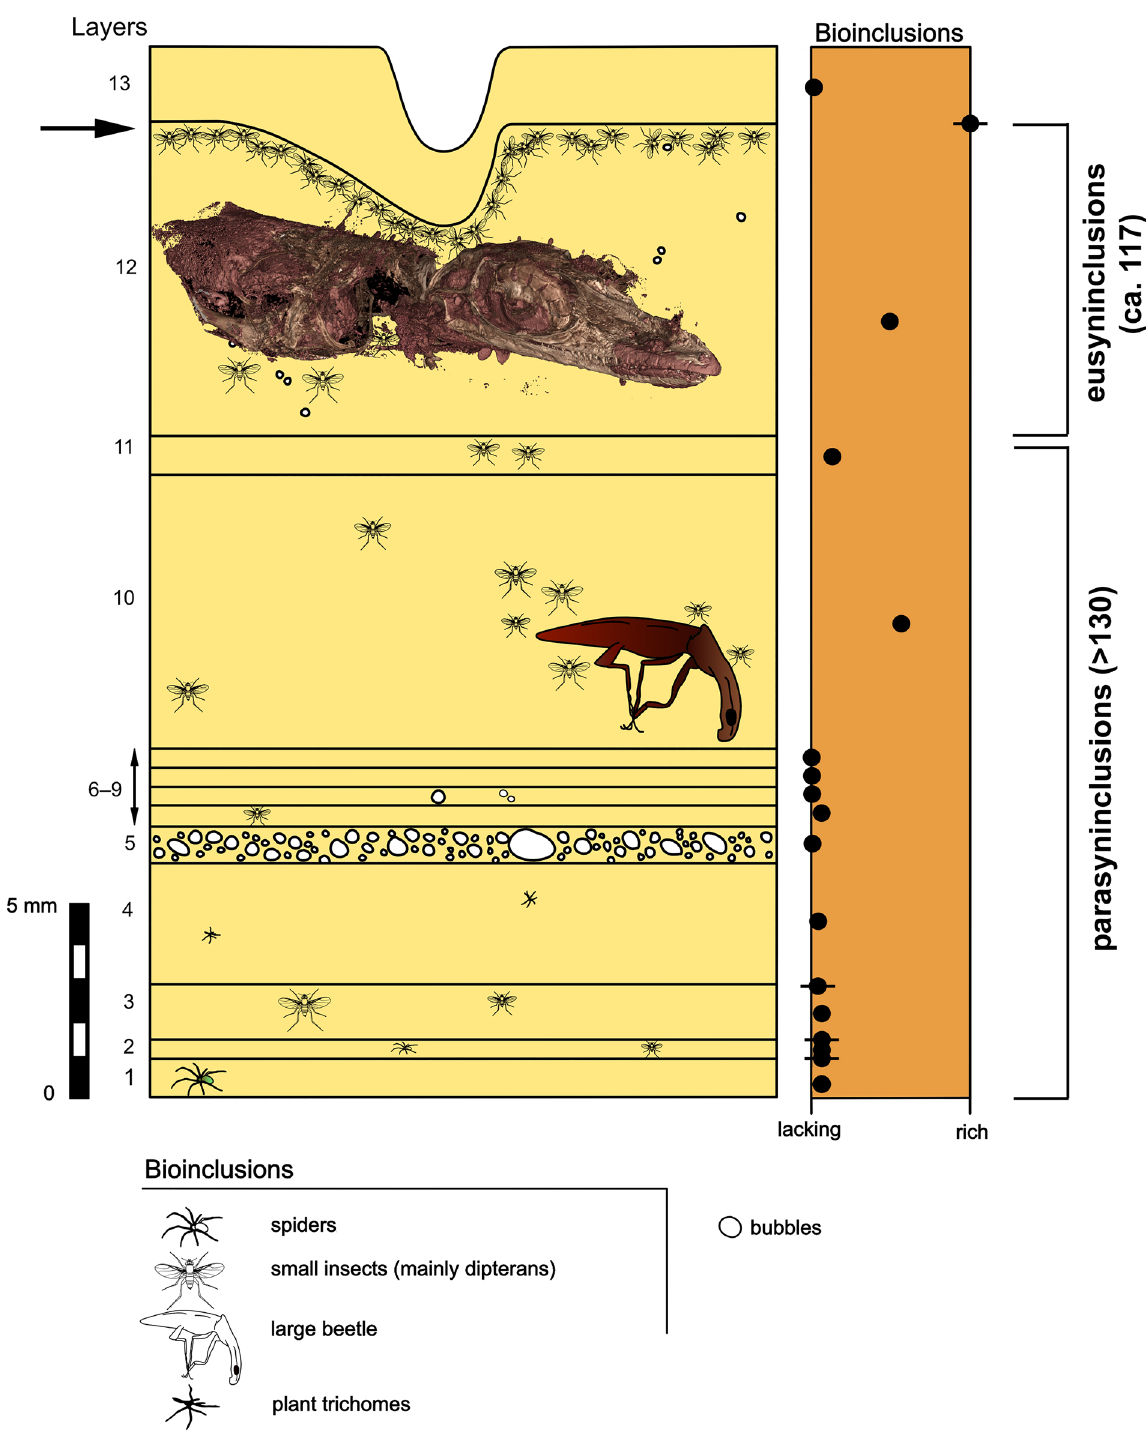
Figure 2. Stratigraphy showing the layers (resin flows) preserved in the piece GRS-Ref-28627 and their contents in a very schematic manner with indication of the different significance, specific for our case of study, of the new terms eusyninclusions and parasyninclusions. The relative abundance in bioinclusions is represented at the right for each whole layer, except to for four layers in which there two indications, the relative quantity of bioinclusions in the top surface as striped points and the remained relative quantity of bioinclusions as a point at the middle of the layer; arrow indicates the interesting surface plenty of necrophagous dipterans, which is the top of the layer 12 containing the Oculudentavis naga holotype and a large portion of wings of a neuropteran individual. The large beetle most likely is an Elateroidea. The thicknesses of the layers represented are the greater observed, but they vary along the two apices of the piece and also as observed in their contacts with the two surfaces of the piece in sides A and B (these sides are illustrated in Fig. 4A—the side A- and Fig. 4C—the side B-); original thicknesses of layers 1 and 13 greater and represented as preserved. The taphonomy of the piece (mostly of the layers 12 and 13) stablished the chronology from the base (layer 1, the oldest) to the top (layer 13, the younger). Silhouettes of the bioinclusions and bubbles not to the same scale. Produced using Affinity Designer (www. affin ity. serif. com/ de/ desig ner/) and Adobe Photoshop (www. adobe.